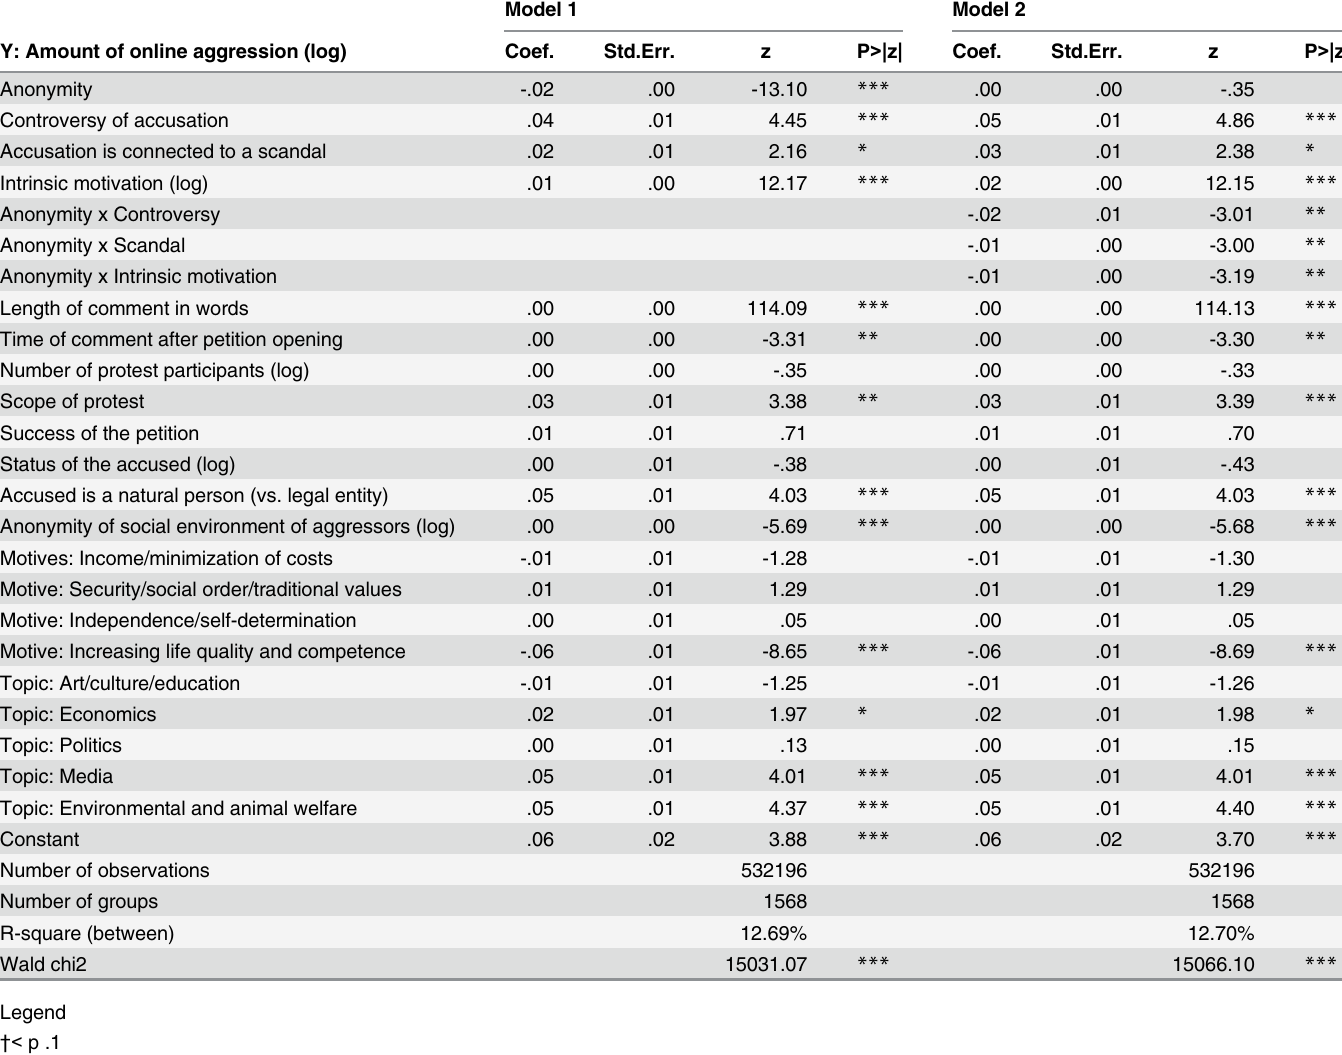
Table 1. Predicted amount of online aggression dependent on the anonymity of aggressors (random-effects regression). Model 1 Model 2 Coef.